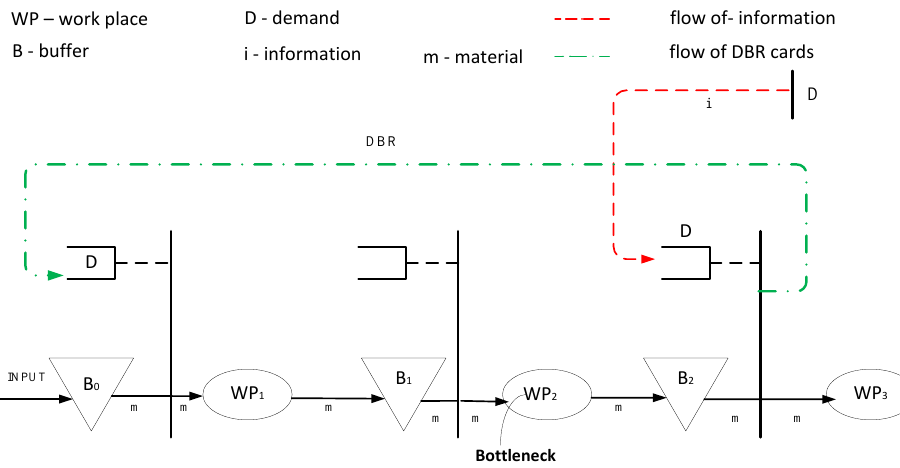
Figure 1. DBR control mechanism.